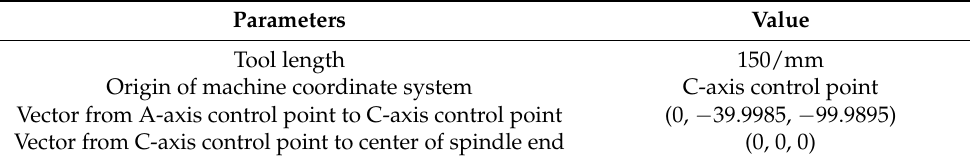
Table 1. The parameters of the KMC400S U five-axis machine tool.